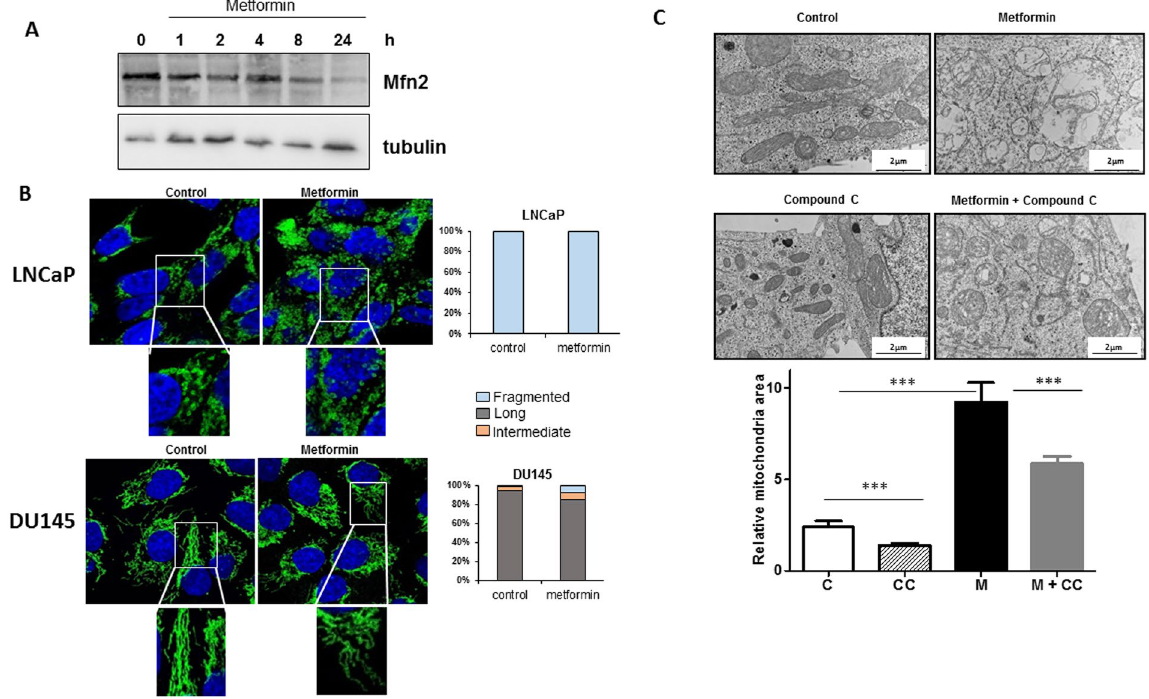
Figure 3. Metformin does not induce fission of the mitochondrial network, and mitochondrial swelling is partially dependent on AMPK. ( A ) LNCaP cells were treated with metformin for the indicated times, and Mfn2 expression was monitored at different time by immunoblotting. ( B ) LNCaP and DU145 cells were treated for 24 h with 5 mM metformin and stained with Tom20 for immunofluorescence analysis. Representative IF images are shown with the quantification of the morphology of the mitochondrial network. The data from the counting of at least 100 cells are shown. ( C ) LNCaP cells were treated with 5 mM metformin for 24 h in the presence or absence of 20 µ M of compound C (CC). Representative electronic microscopy images are shown, and the graph represents the mean of the relative mitochondrial area. For each condition, 60 to 100 mitochondria from several cells were analyzed by EM, p < 0.001 ( ***